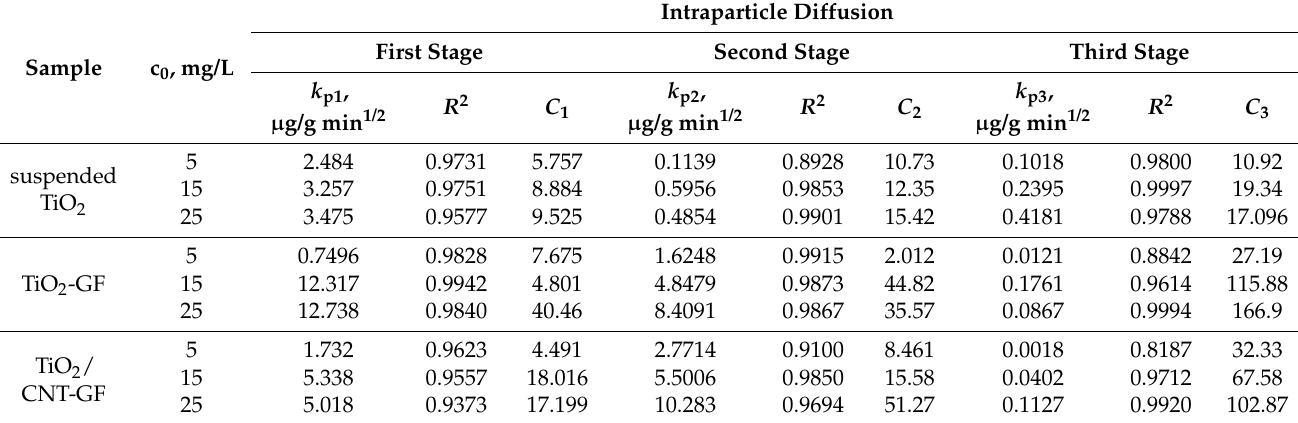
Table 4. Intraparticle diffusion model for